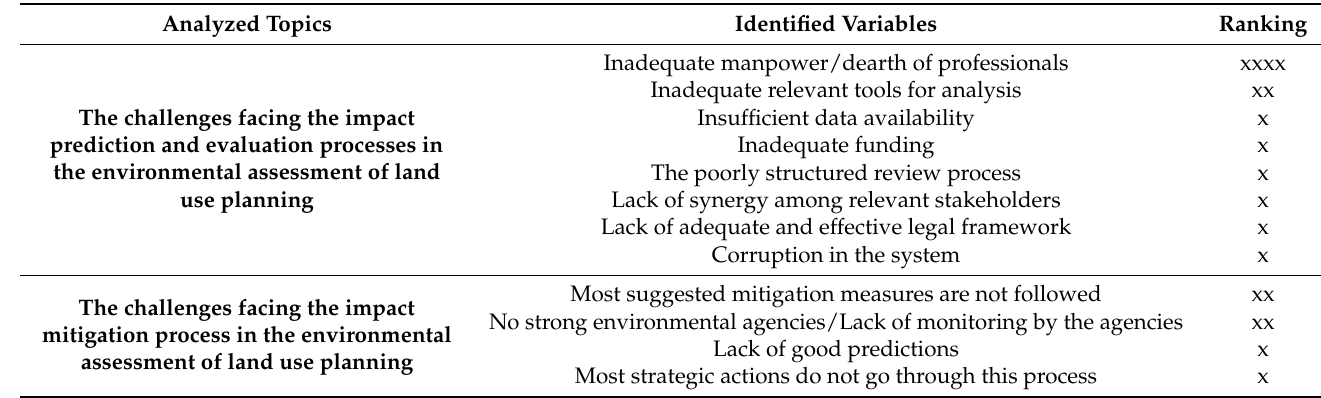
Table 8. Challenges facing the core process in the environmental assessment of land use